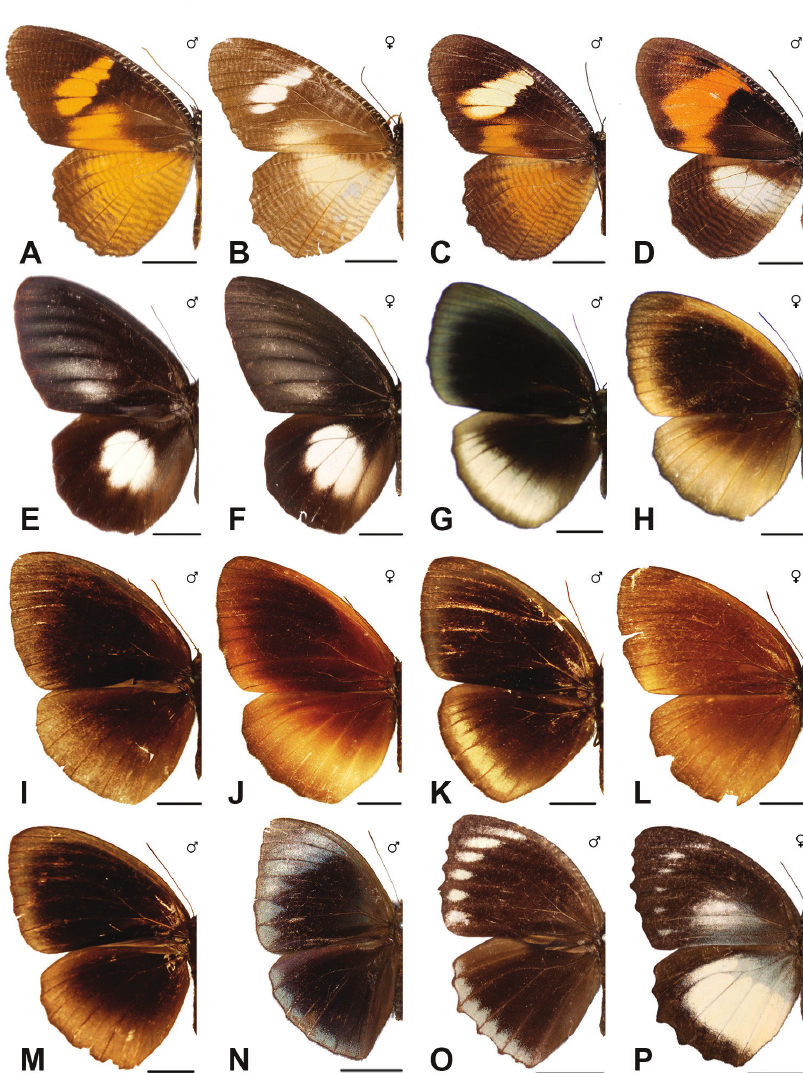
Figure 1. A bammakoo bammakoo ♂ D NHM central Africa B bammakoo bammakoo ♀ D NHM collection locality unknown C bammakoo bammakoo ♂ D NMNH Central African Republic: Ban- gui D bammakoo rattrayi ♂ D NMNH Uganda: Bwamba E paradoxa ♂ D NHM Indonesia: